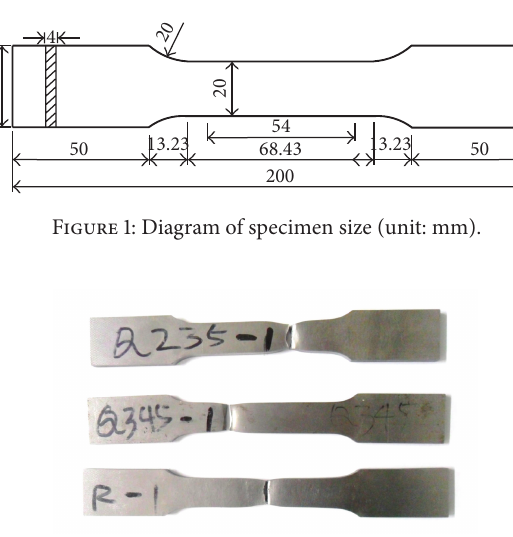
Figure 2: Specimens with tensile fracture.